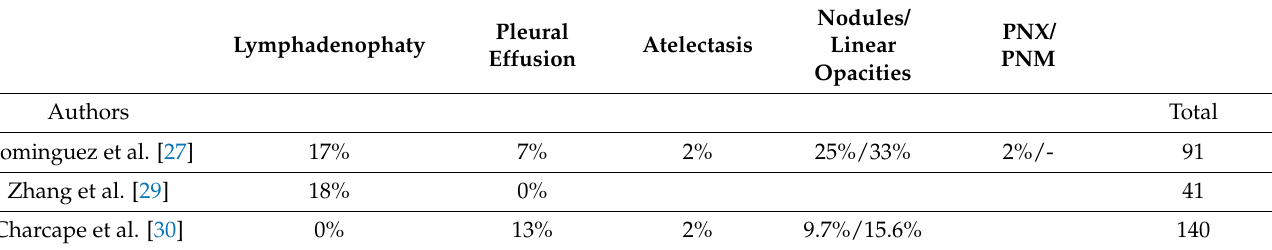
Table 2 summarizes all the studies reported in Section 3: Children’s “Atypical” And “Complicated” Thoracic COVID-19 Manifestations. Table 2. Children’s “Atypical” and “Complicated” Thoracic COVID-19